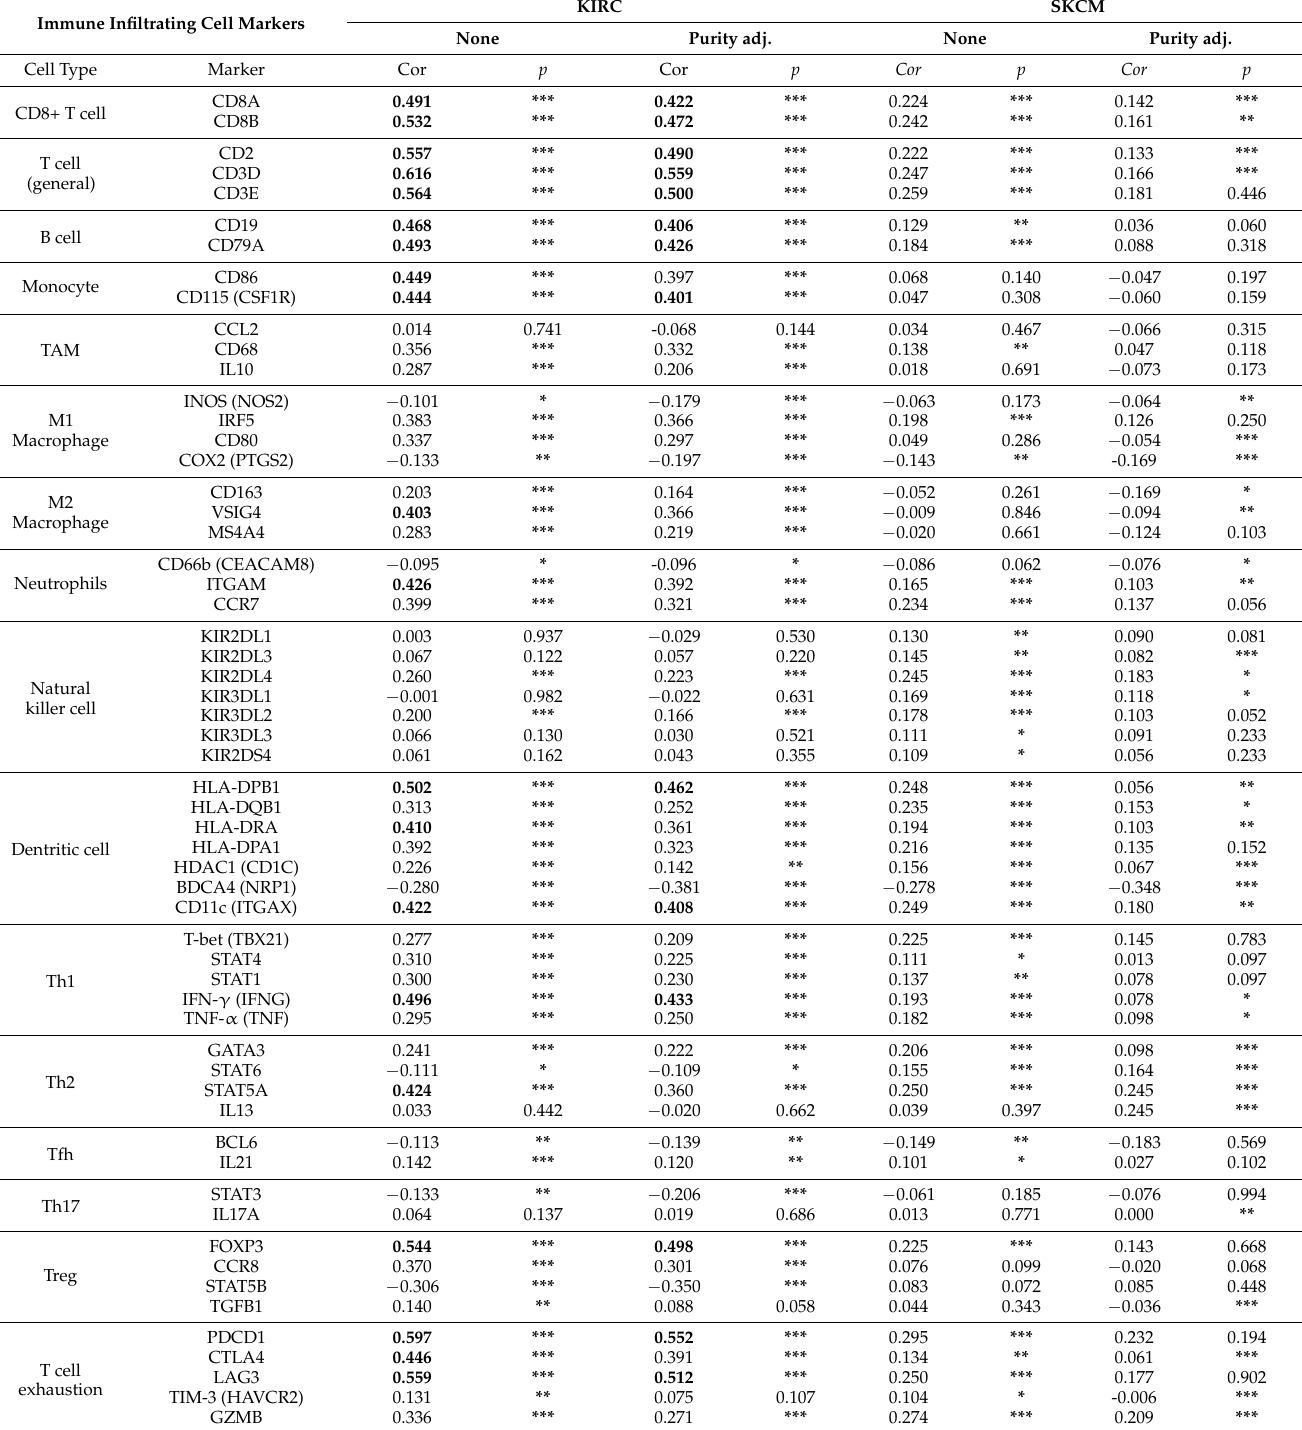
Table 1. Associations between cell signature of immune infiltrating cells and PYCARD mRNA expression in KIRC and